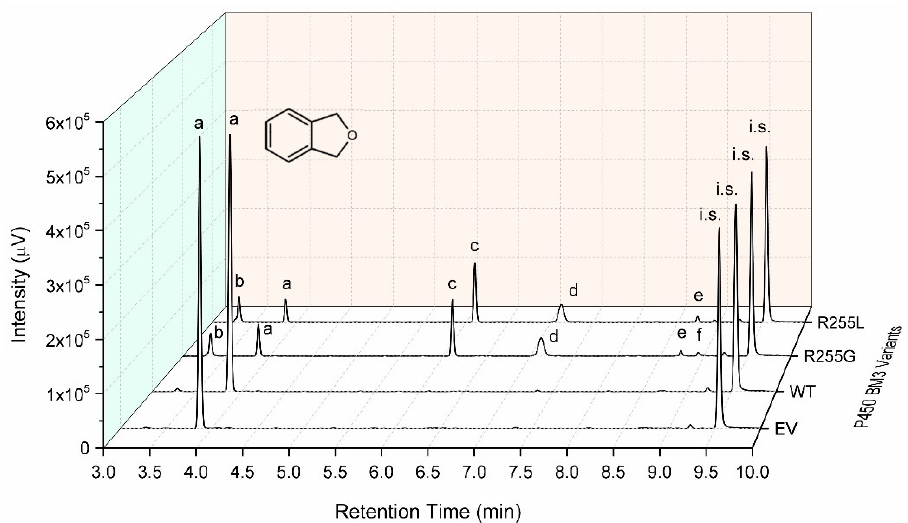
Figure A13. Product analysis via GC-FID after conversion of phthalan with lysate from EV (negative control), P450 BM3 WT, and from variants R255G and R255L. The data was obtained from 1 h conversion reactions employing GDH for efficient NADPH cofactor regeneration. a—phthalan, i.s.— cyclododecanol, b, c, d, e, f—unknown product. A nearly 90% phthalan depletion is visible for both R255G and R255L, whereas WT can only convert 6 ± 1%.